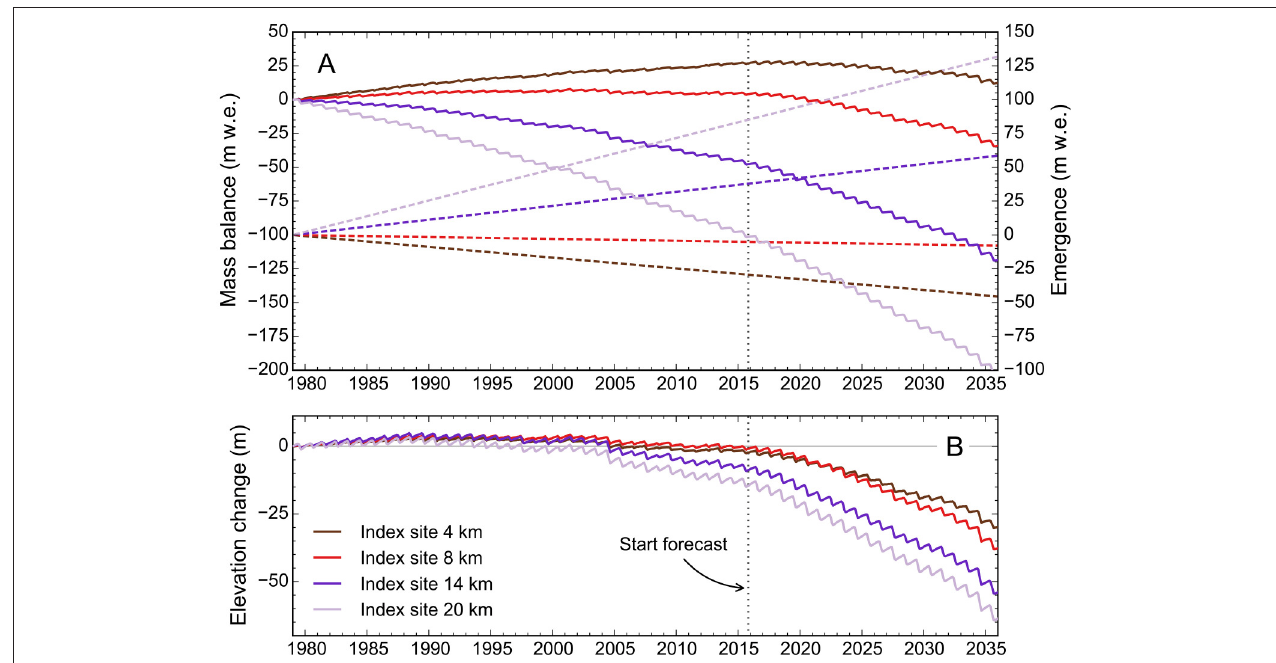
FIGURE 13 | (A) Cumulative daily surface mass balance (solid lines, left axis) and ice flow emergence (dashed lines, right axis) for four selected index sites in the surge reservoir, over the time period 1979–2035. (B) Cumulative elevation change, corresponding to the difference between surface mass balance and flow emergence. The vertical scale in (B) is twice as large as in (A)